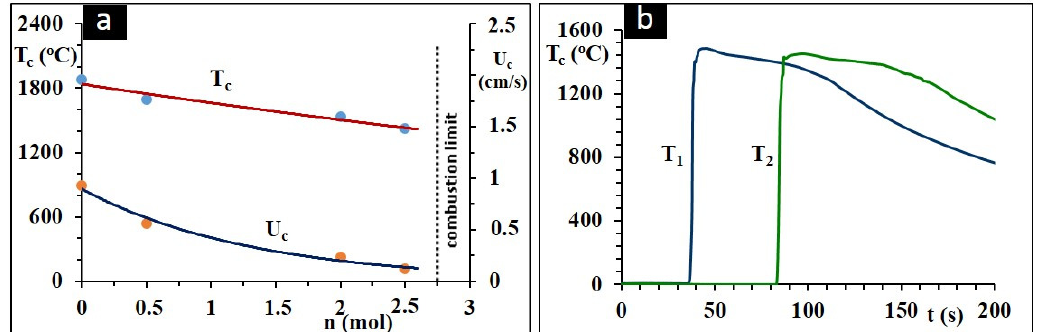
Figure 1. Combustion law for Ti + 2B + n Si system ( a ), and combustion thermograms of Ti + 2B + 2Si mixture ( b ) at P (Argon) = 1 MPa.